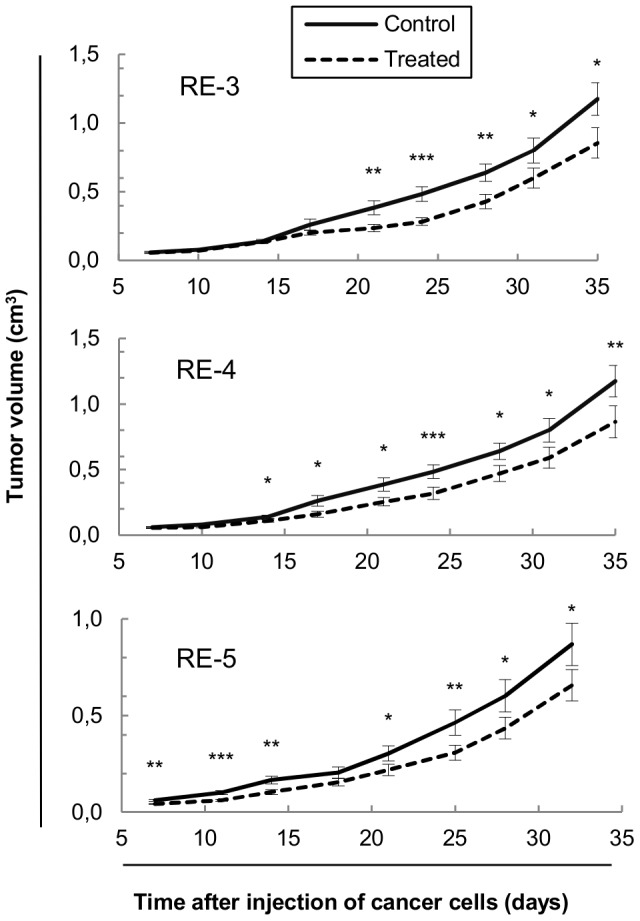
Antitumorigenic activity of different RE's in human colon cancer xenografts.RE (test groups) or vehicle (control groups) was administered to nude mice bearing SW620 colon cancer xenografts in the drinking water (1 mg RE and 20 μL ethanol as vehicle per mL of drinking water). Three RE's with different composition (RE-3, RE-4 and RE-5, indicated in each graph) were assayed. Tumor volumes were monitored twice a week during 32–35 days. Results are shown as mean ± SEM (n = 16–20) and repeated measures ANOVA with Bonferroni's test was used to determine the statistically significant differences between treated and control groups (*p≤0.05; **p≤0.01; ***p≤0.001). RE: supercritical rosemary extract.